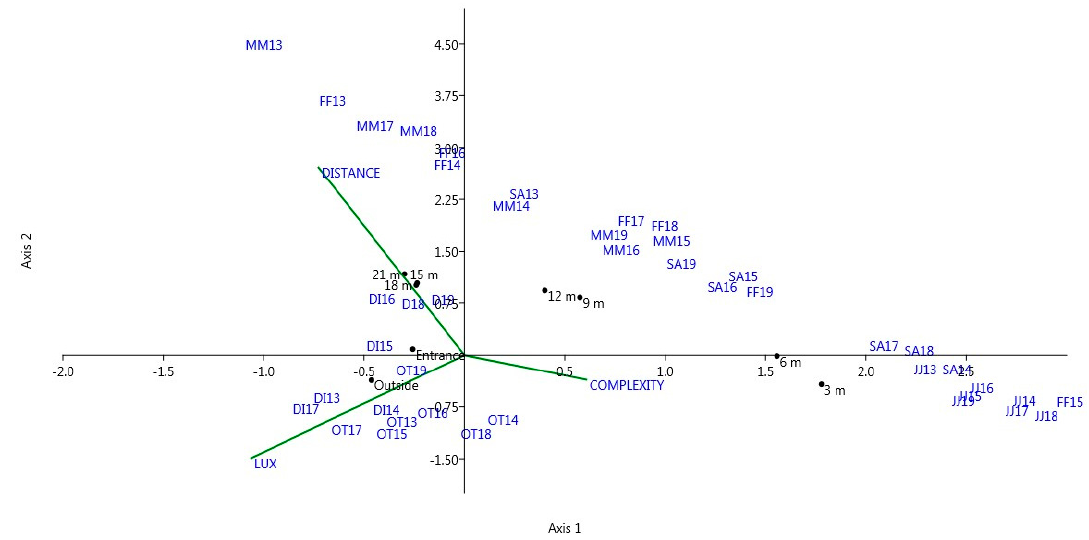
Figure 2. Canonical correspondence ordination diagram of the faunal community sampled from 2013 to 2019 in the Biospeleological Station of San Bartolomeo. DI = dipterans, FF = female salamanders, JJ = juvenile salamanders, MM = male salamanders, OT = other invertebrate taxa, SA = subadult salamanders. The number following the symbols indicate the year of sampling. COMPLEXITY is the wall heterogeneity, DISTANCE is the linear distance from the entrance and LUX is the illuminance. Dipterans (DI) and the other taxa of invertebrates (OT) were projected in the left lower quadrant of the plot, while salamanders were linearly spread in along the diagram, with juveniles and subadults always projected on the right and females and males in the center and left quadrant (Figure 2). There was a strong repeatability of this pattern among years with only one exception, the position of female salamanders sampled in 2015 (i.e., FF15 in Figure 2), that was associated with juveniles and subadults on the rightmost part of the plot. The distribution of trapping sites on the CCA plot was also noteworthy, because the two more external sites (i.e., Outside and Entrance) were projected in the lower left quadrant in association with all the invertebrate taxa. Conversely, all the others sites were distributed on the right part and the upper part of the CCA plot, apparently associated with the salamanders’ groups. Concerning environmental factors, LUX had the highest load on the first axis, while DISTANCE had the highest load on the second axis (Supplementary materials; Table S3).